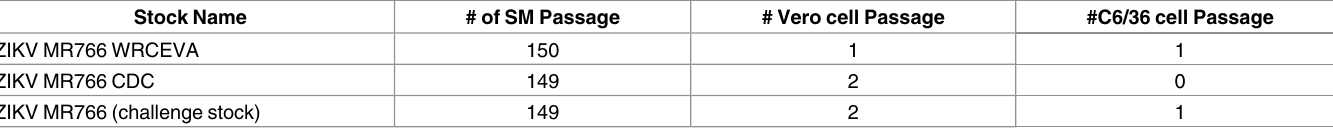
Table 1. Summaryof virus stocks and culture history. All Zika virus strains are the MR 766 prototypestrain derivedfrom the virus that was isolatedfrom a sentinelrhesus monkey in Zika Forest, Entebbe, Ugandain April 1947[6]. All have undergone extensive mouse brain passage.The MR766 challenge stock was created for nonhuman primate natural history studies and was derivedfrom the CDC virus. Challengevirus was preparedby inoculation of CDC virus onto a confluentmonolayerof C6/36 mosquitocells and a clarified harvest of the culture medium was collectednine days post infection. Stock